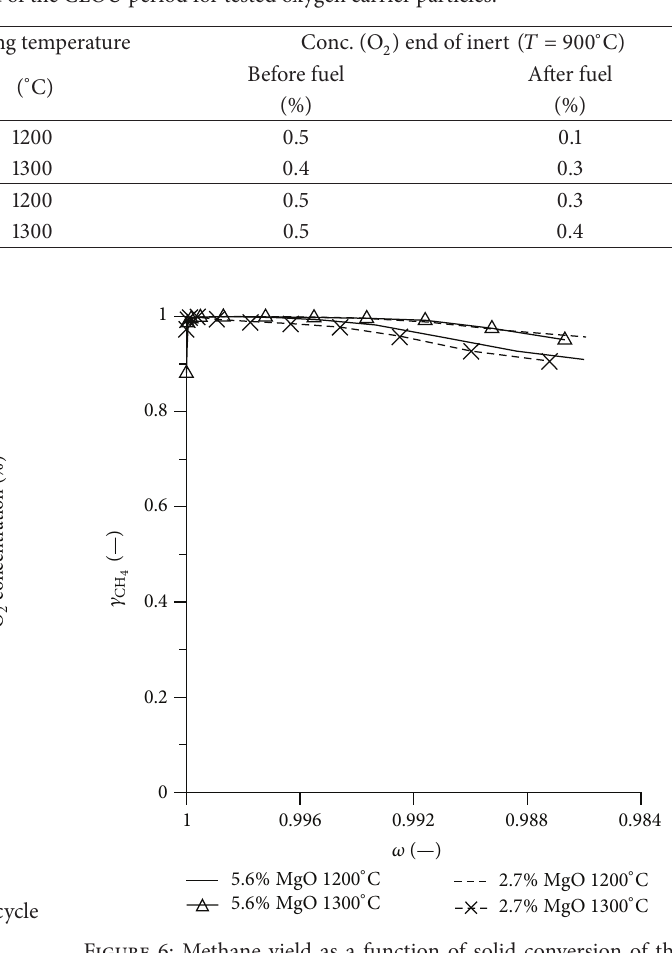
Table 6: Oxygen concentration at the end of the CLOU period for tested oxygen carrier particles.